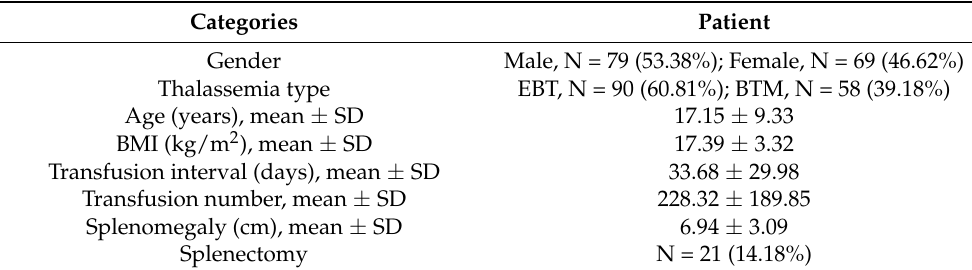
Table 1. Baseline information of the patients enrolled in this